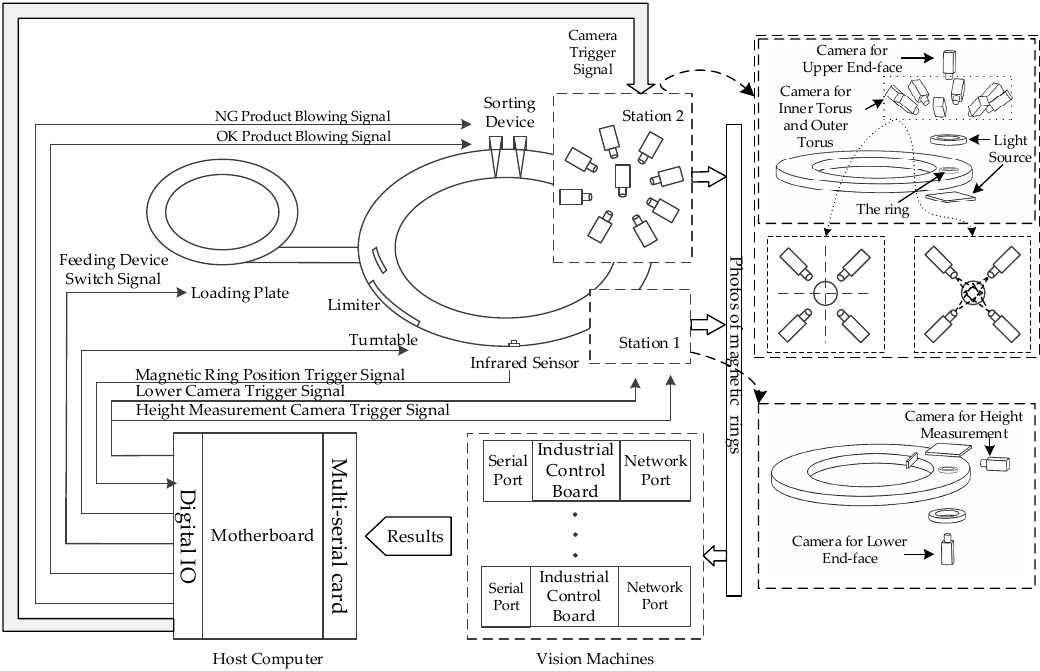
Sensors 2020 , 20 , x FOR PEER REVIEW Figure 4. Total plan of the magnetic ring defect detection system. Figure 4. Total plan of the magnetic ring defect detection system.